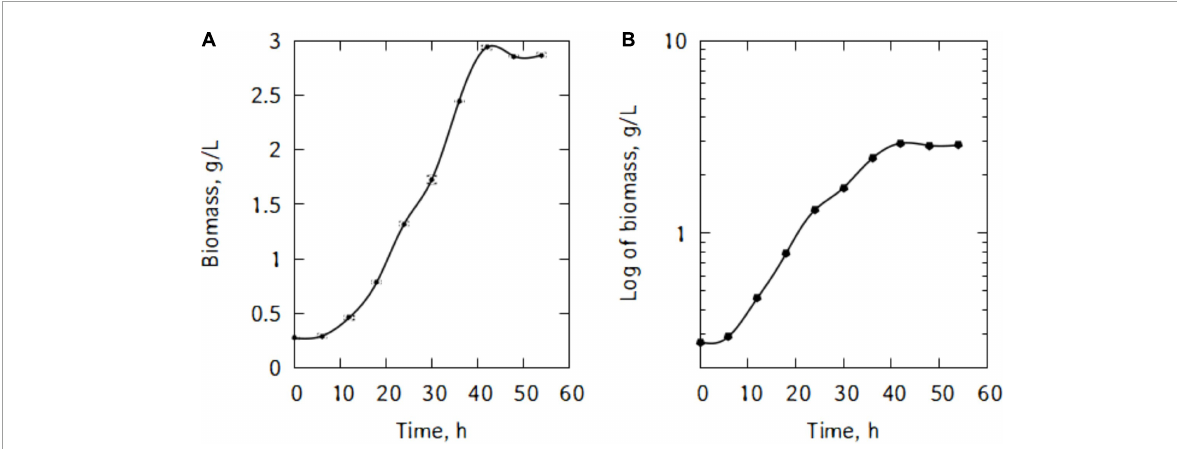
FIGURE1 Growth of P. taetrolens in traditional cheese whey (A) , logscale (B) .